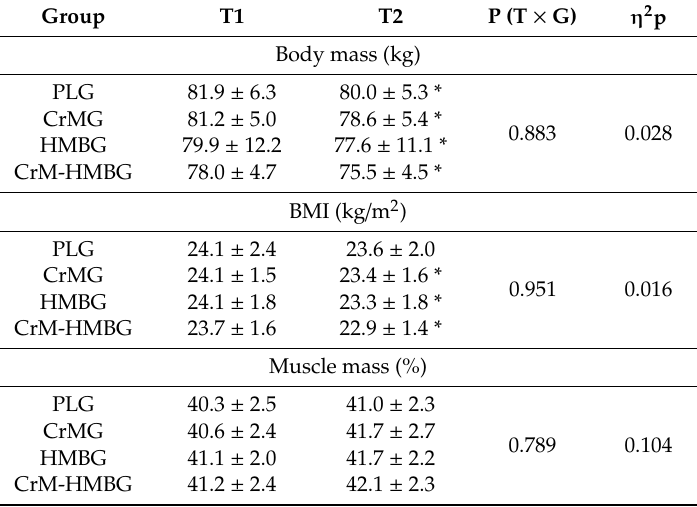
Table 2. Anthropometry and body composition of